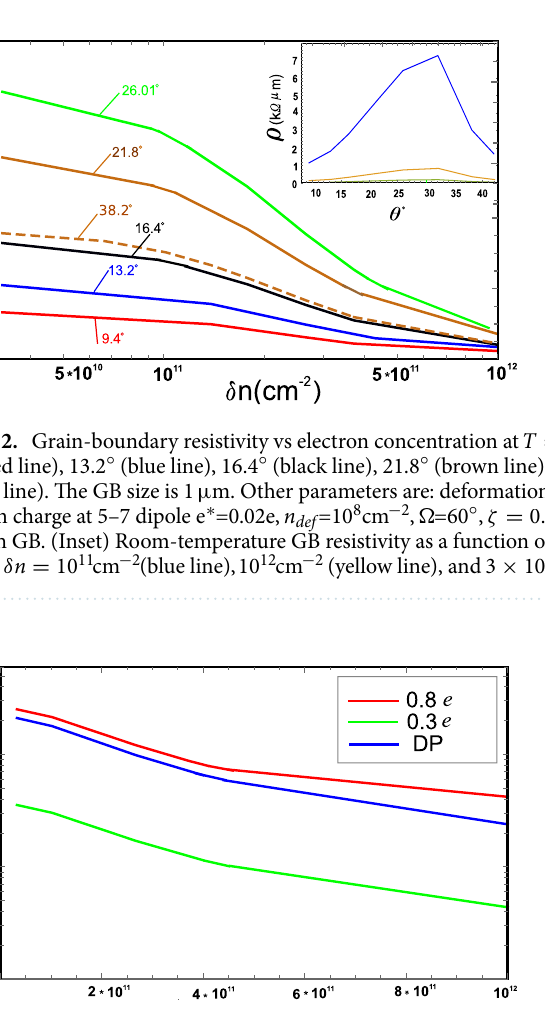
Figure 3. GB resistivity caused by electrostatic potential versus electron concentration at T 0.3 e (green line) and e 0.8 e (red line). The GB misorientation angle is taken to be effective charges e ∗ ∗ = = 13.2 0.246 nm, h 0.846 nm, p =916). For comparison, the resistivity due to deformation potential θ ◦ ( L = = = (DP) scattering from Fig. 2 is shown by blue